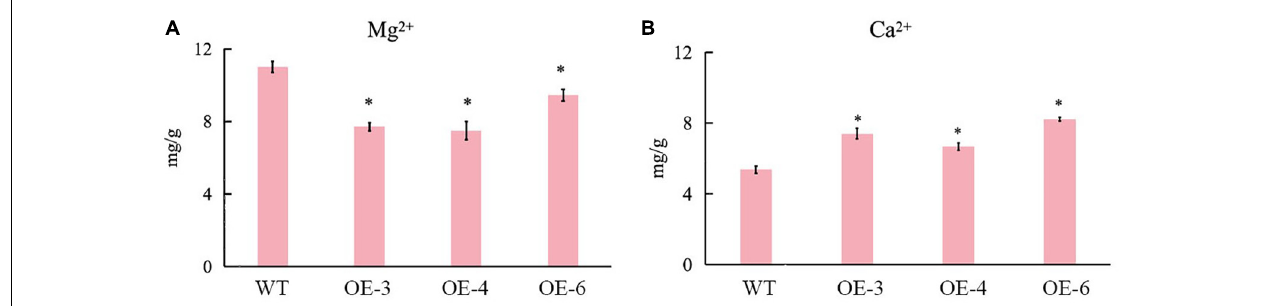
FIGURE 10 | The concentration of (B) Ca 2 + and (A) Mg 2 + in WT and SlCCX1-LIKE-OE plants of 25 days seedlings. The experiments were repeated three times. Error bars indicate the means ± SE of three independent replicates. *Significant differences with P < 0.05 determined using a Duncan’s test compared with the control.